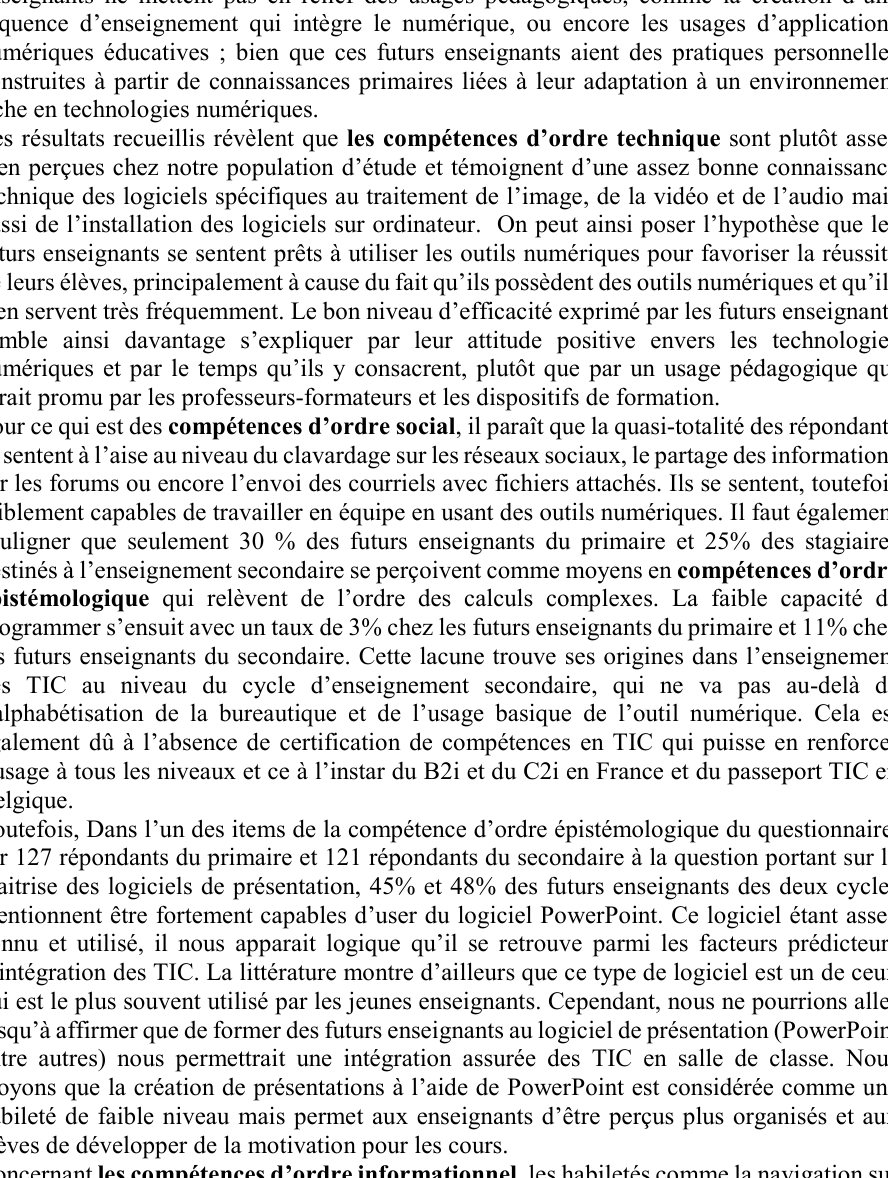
Fig. 11. Les compétences techno-pédagogiques déclarées maîtrisées à l’issu de la formation au